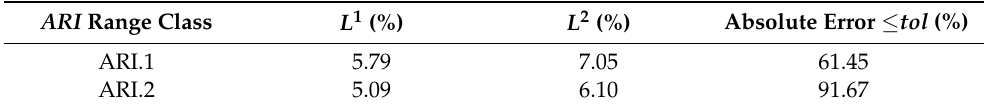
Figure 4. Example 3.0.1. Predicted temperature versus monitored and outdoor temperatures inside a TR3 courtyard. Table 8. Example 3.0.1. Statistical parameters for the courtyard measured temperature in each selected courtyard of each temperature range class.